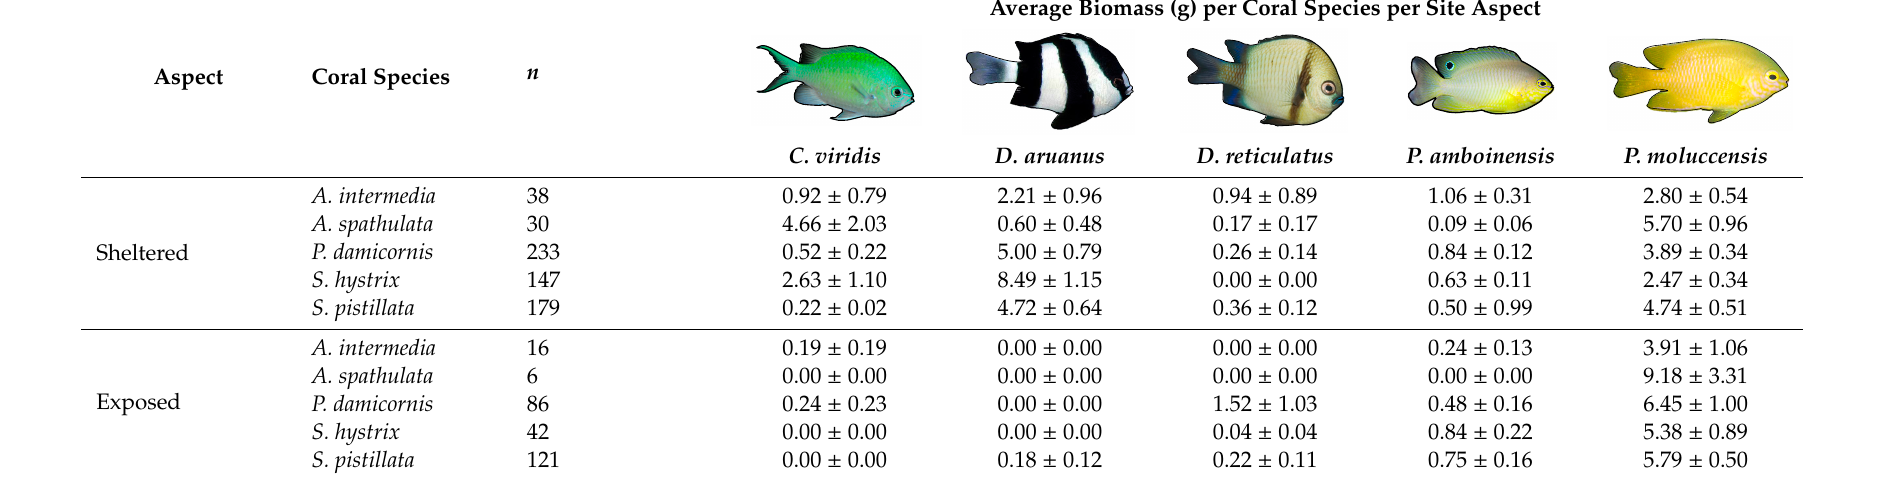
Table 3. Average biomass estimates (mean ± SE) for each damselfish species ( Chromis viridis, Dascyllus aruanus, Dascyllus reticulatus, Pomacentrus amboinensis , and Pomacentrus moluccensis ) on each coral species ( Acropora intermedia, Acropora spathulata, Pocillopora damicornis, Seriatopora hystrix , and Stylophora pistillata ) on occupied colonies in sheltered and exposed aspect sites.